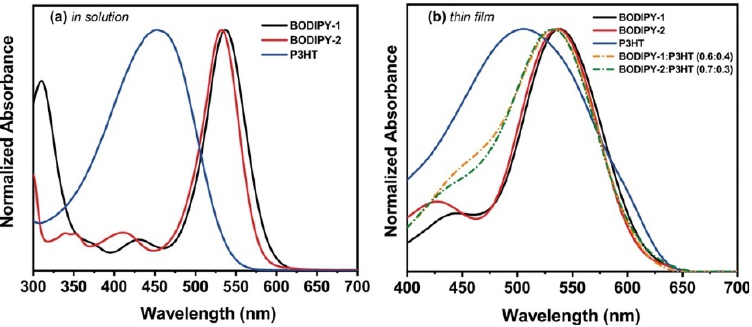
Figure 2. ( a ) Normalized absorption spectra of BODIPY-1 , BODIPY-2 and P3HT in chloroform. ( b ) Normalized absorption spectra of BODIPY-1 , BODIPY-2 , P3HT, BODIPY-1 :P3HT (0.6:0.4) and BODIPY-2 :P3HT (0.7:0.3) films.